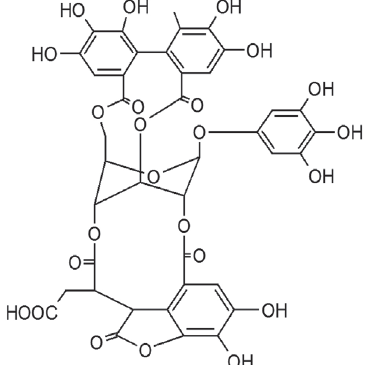
FIGURE 1 - Chemical structure of